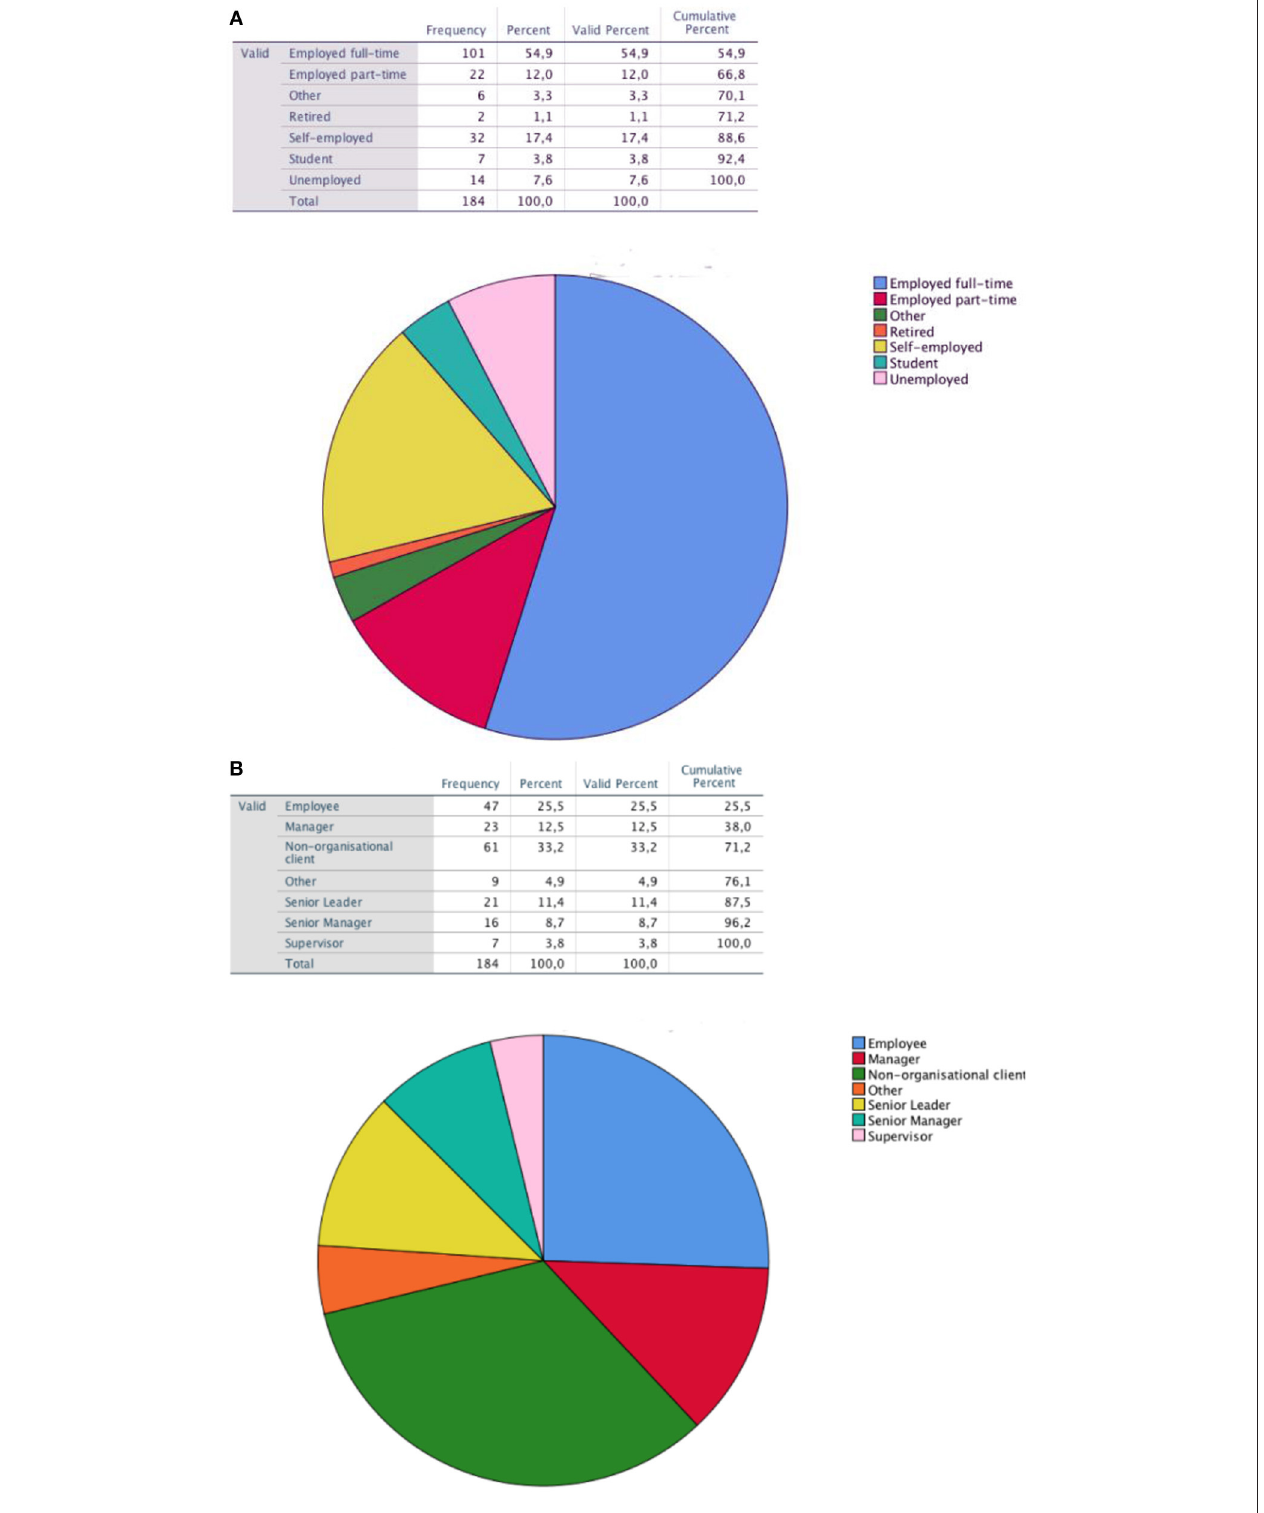
FIGURE 5 | (A) Client employment category. The pie chart depicts the distribution of clients’ category of employment by 7 categories ranging from full-time employment to unemployment. (B) Client position in organization. The pie chart depicts the distribution of clients’ level of employment by 7 categories ranging from employee to